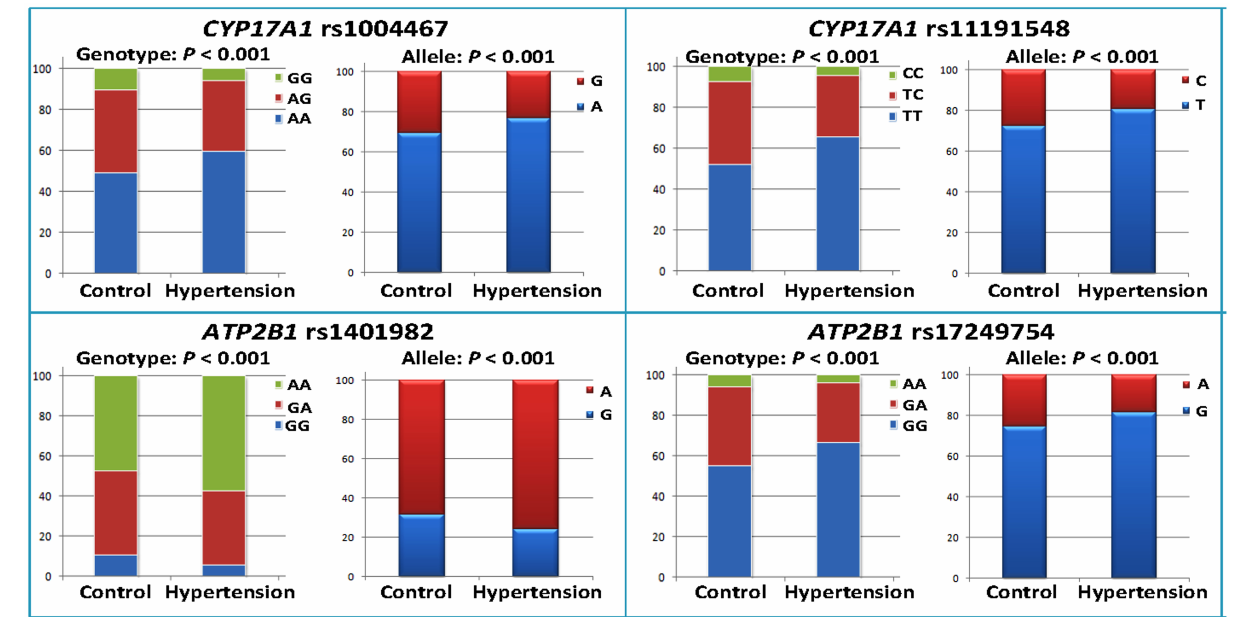
that is influenced by various environmental elements, small effect polygenes, and their interactions (44). The genotype and allele frequencies of the CYP17A1 – ATP2B1 SNPs are